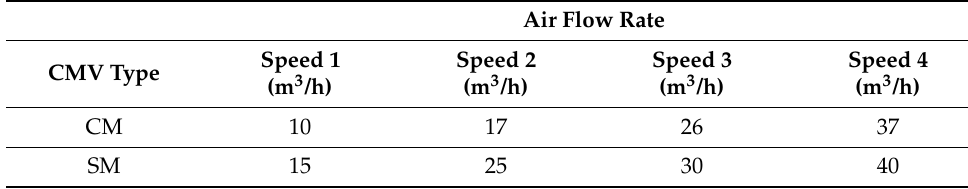
Table 2. Air flow rates at different factory speeds